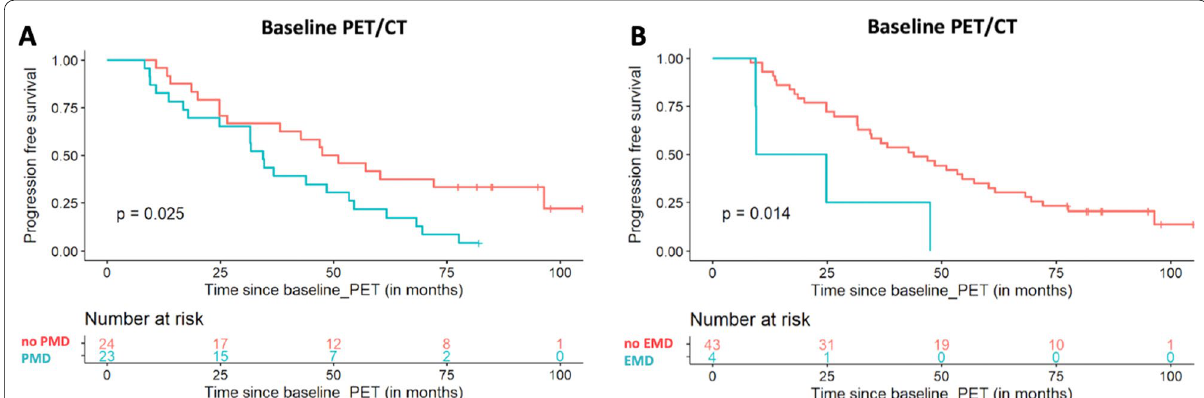
Fig. 5 Kaplan–Meier estimates of PFS according to the presence of PMD ( A ) and EMD ( B ) at baseline PET/CT. The numbers of patients at risk in each group and for the respective time‑points are shown below the